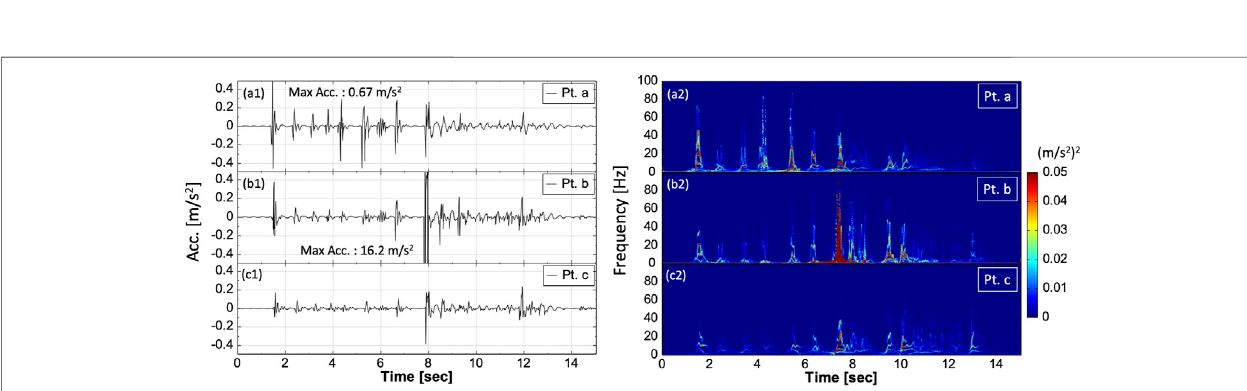
FIGURE6| Seismicsignalsandtheircorrespondingtime – frequencyspectraofthesinglelargerockfalltest(Test2).T1:37.6 s,therock fi rstimpactingontheslope; T2: 42.6 s, the rock arriving the slope toe; T3: 44.6 s, the rock impacting on the bank; T4: 45.1 s, the rock impacting on the creek bed; and T5: 47.6 s, the rock stop.